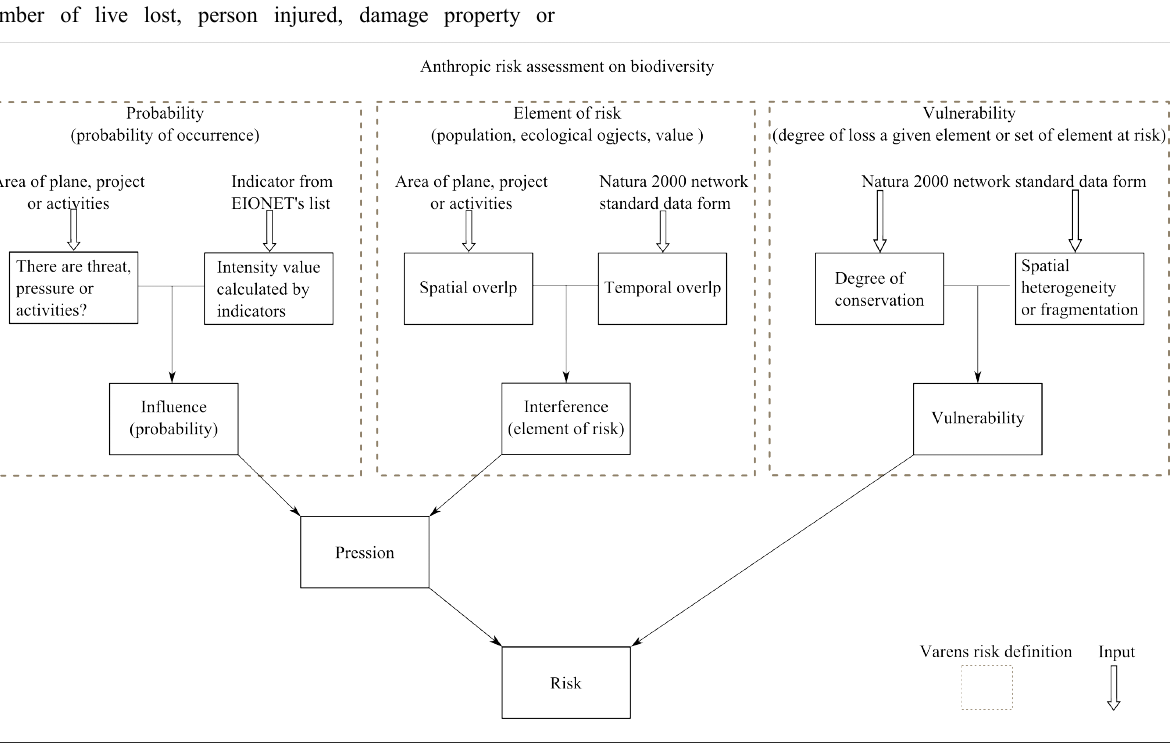
Figure 1. Anthropic risk assessment flow